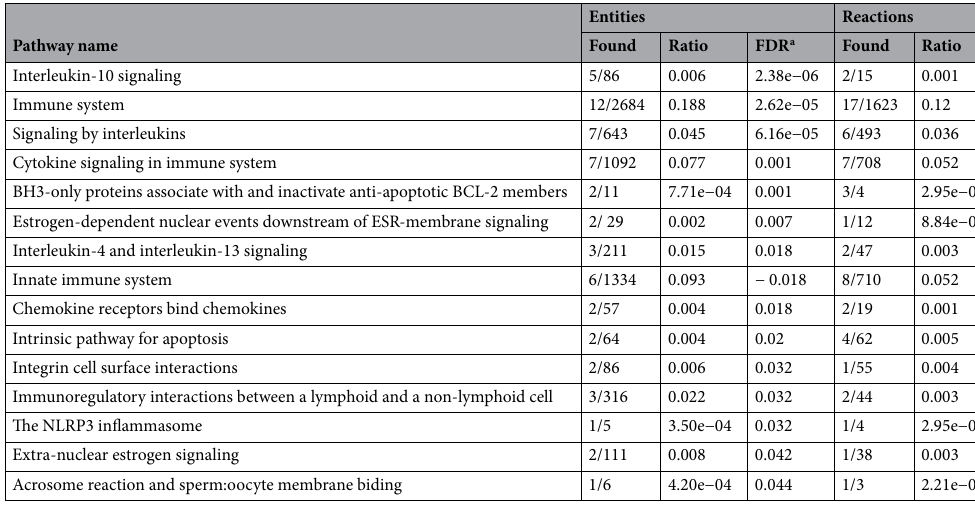
Table 3. Reactome pathways sorted by p-value for the 10 differentially expressed genes at baseline by cluster. a False discovery